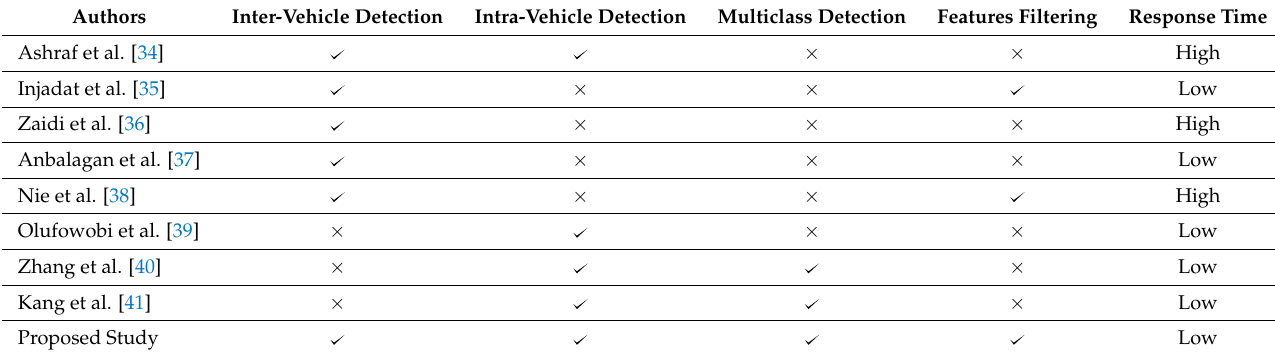
Table 1. A comparison of existing studies related to intrusion detection in IoV.